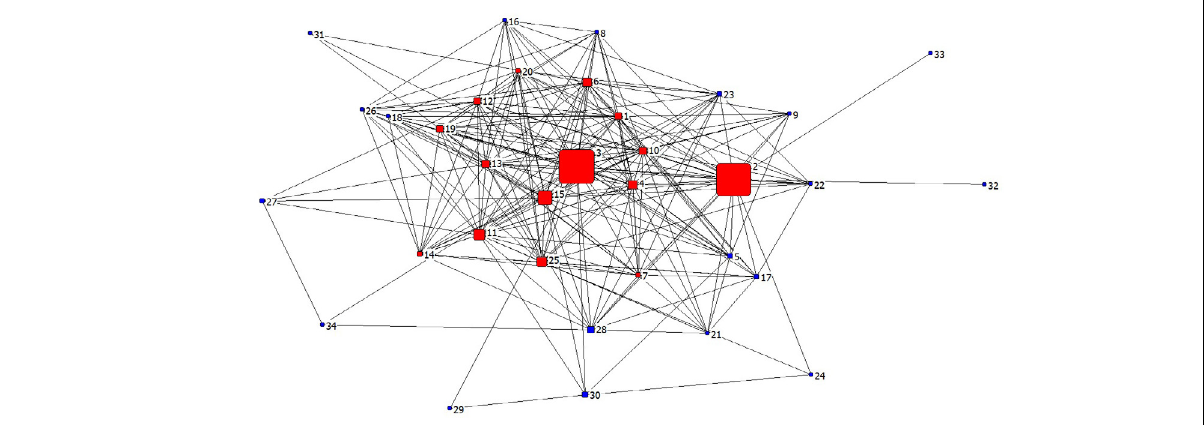
Figure 2 : Dassenberg Coastal Catchment Partnership governance network. Red nodes show the core actors and blue nodes show the peripheral actors. Node size indicates betweenness centrality. The numbers identify each actor as listed in Table